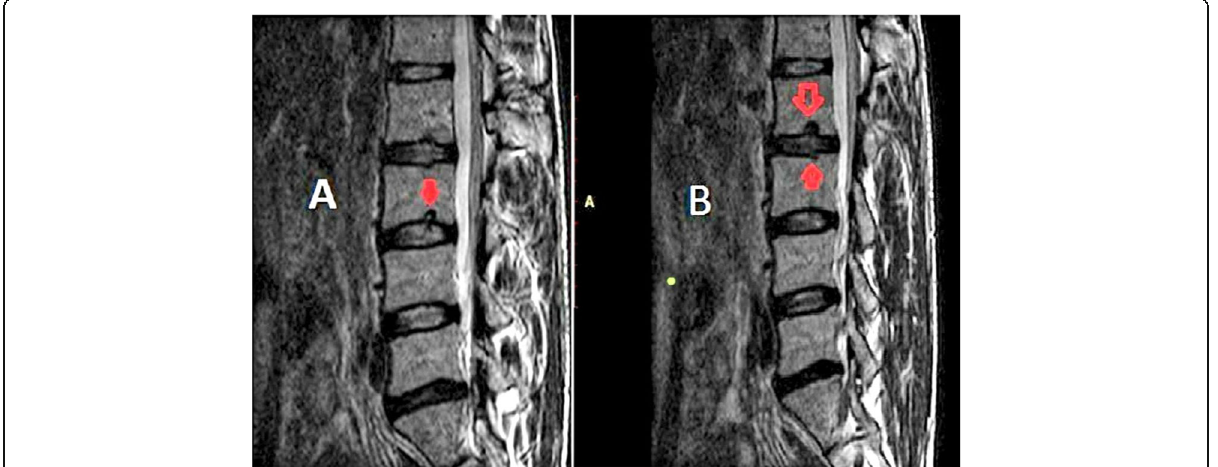
Fig. 1 A 48-year-old man with 6 months of lower back pain. T2-weighted sagittal magnetic resonance turbo spin echo ( a, b ) (echo time = 100 ms, repetition time = 2363 ms) showing SN in the lower end plate of L3 vertebra in a and in the lower endplate of L2 and upper endplate of L3, associated with score 1 degeneration at L2 – L3 disc in b .